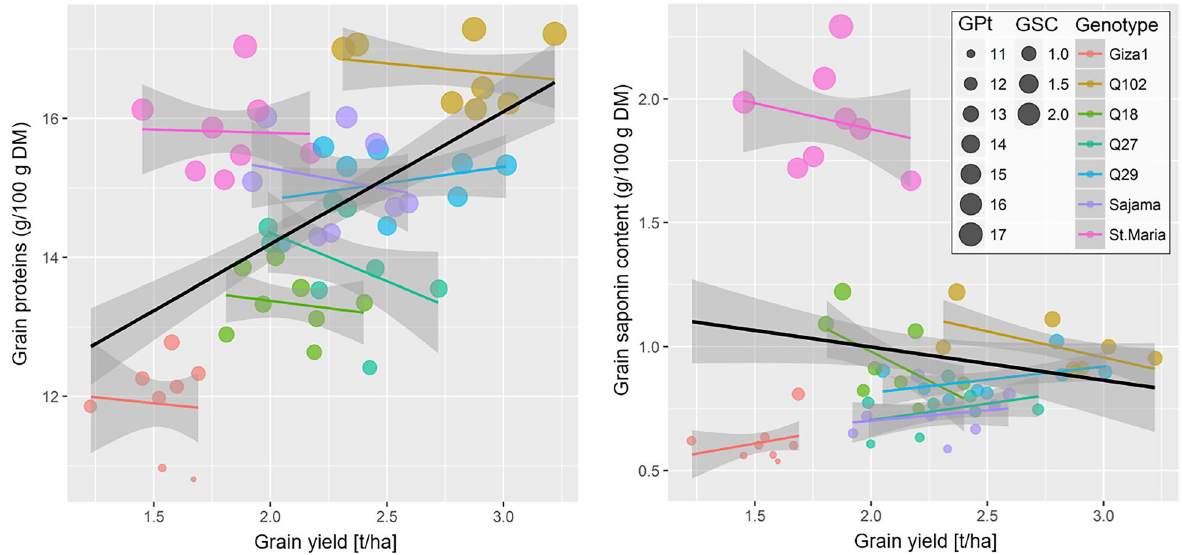
Figure 9. Relationship between grain yield and grain nutritional quality for different quinoa ( Chenopodium quinoa ) genotypes grown in open field under hot-arid conditions. The color of points is mapped to genotypes, and size values are set to values of grain proteins (GPt) and saponins (GSC). The solid lines (black for all genotypes combined, colors for studied genotypes) represent a linear regression with a GLM fit, with 95% confidence regions in light